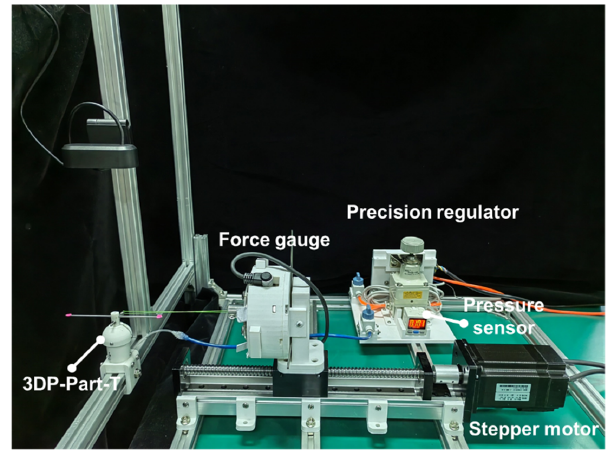
( b ) Figure 9. Experimental results of the rotational stiffness of the VSBJ at different input air pressures: ( a ) Schematic illustration of the point of application of the pulling force; ( b ) torque-angle curves at different air pressures. 3.2. Twisting Stiffness Evaluation The experimental setup for evaluating the twisting stiffness of the VSBJ was illus- trated in Figure 10. The methods of measuring the pulling force and twisting angles were the same as that used in the measurement experiments for rotating stiffness. A 3D printed